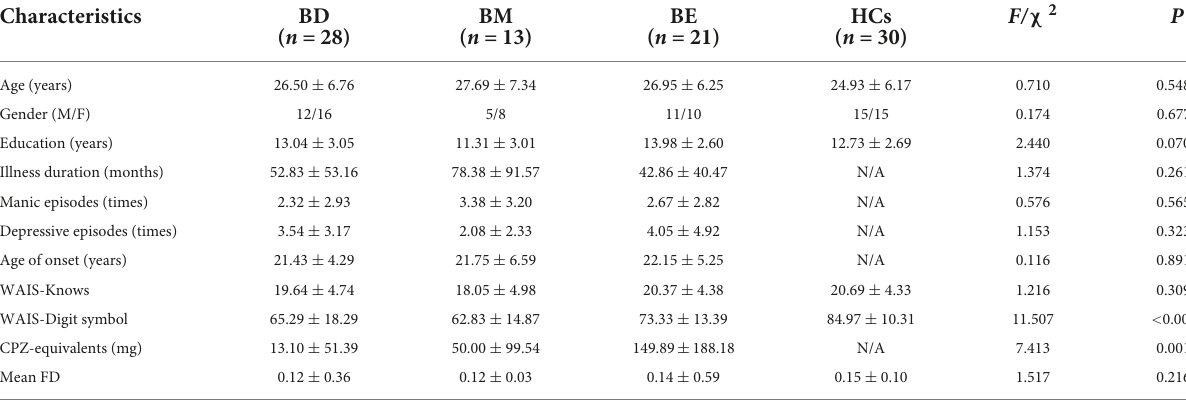
TABLE 1 Cohort demographics and clinical